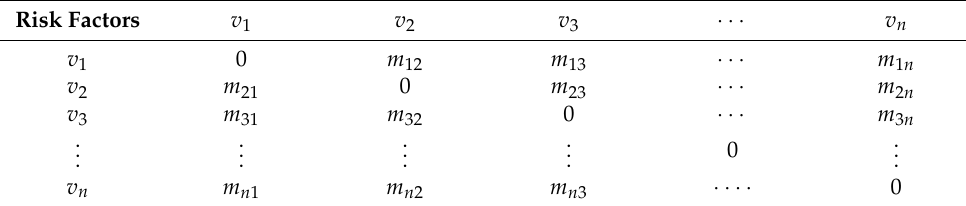
Table 3. Risk factor adjacency